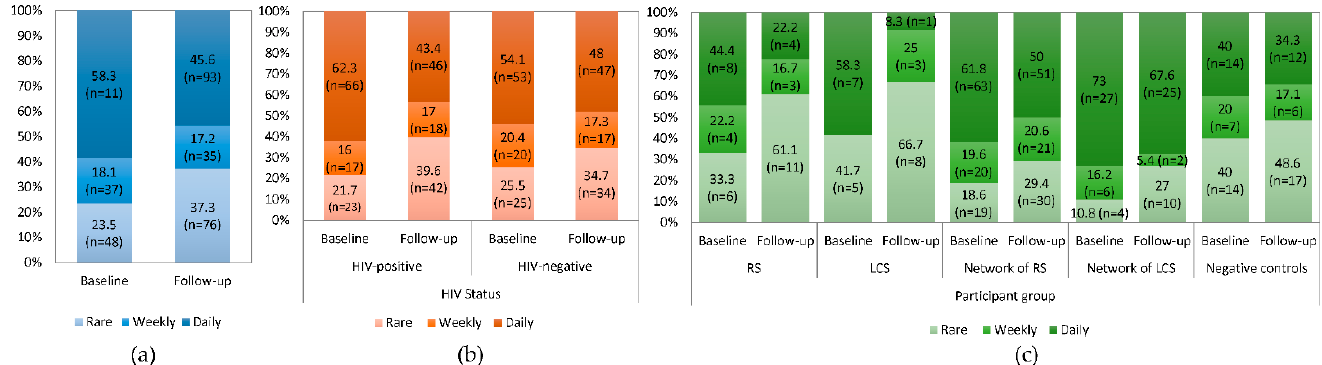
Figure 2. Frequencies of the responses to questionnaire Q3 (How often did you inject drugs? This includes occasions when someone else injected you) ( n = 204), at baseline and follow-up of Transmission Reduction Intervention Project (TRIP) ( a ) all participants, ( b ) by human immunodeficiency virus (HIV) status, and ( c ) by participant group. Abbreviations: RS, recent seeds; LCS, control seeds with long-term HIV infection.